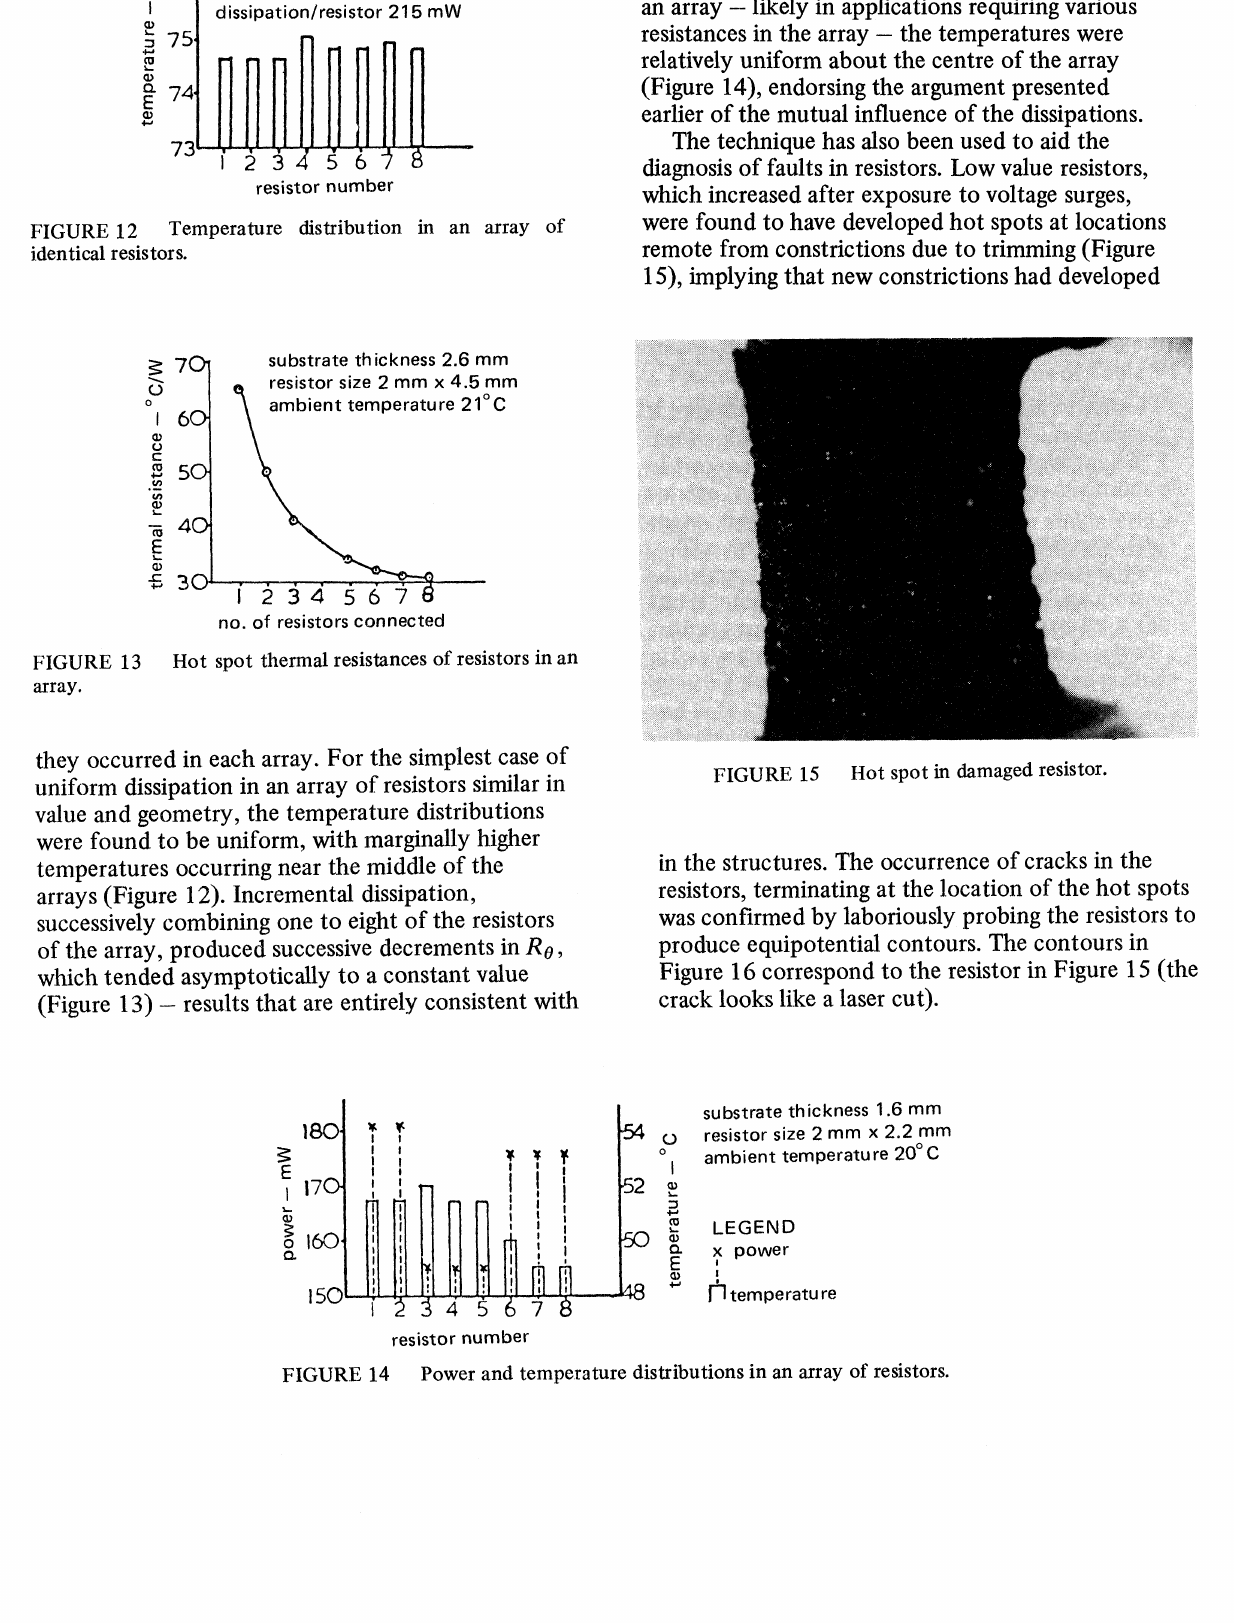
FIGURE 12 Temperature distribution in an array of identical resistors.